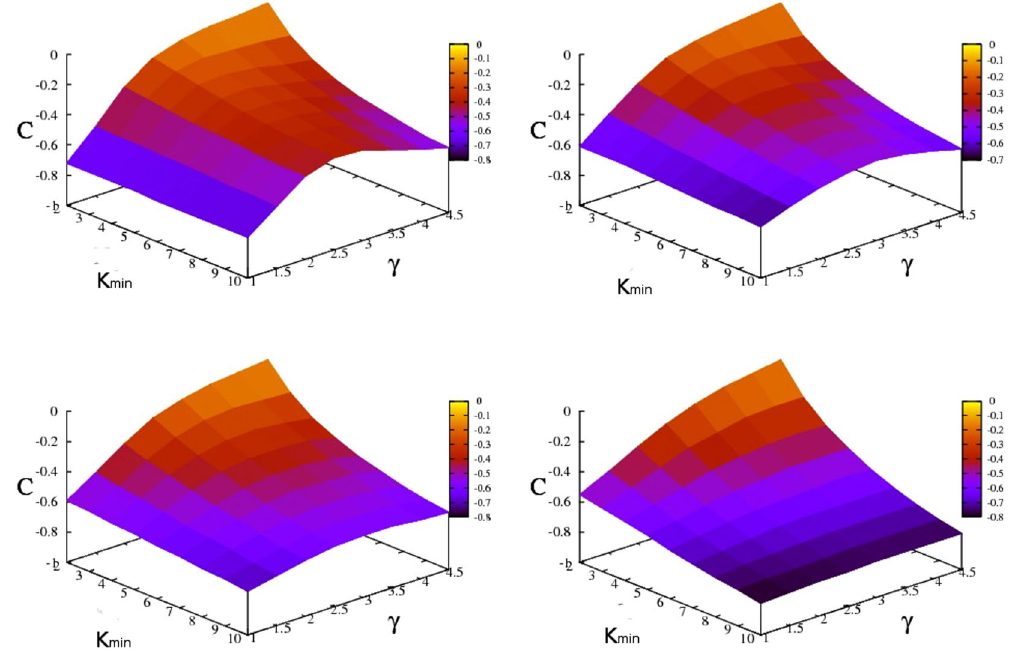
Figure 4. Pearson correlation coefficient C ( γ , K min , K max ) for GSFNs with N = 1000 and K max equals N − 1 (top left), 100 (top right), 50 (down left), and 20 (down